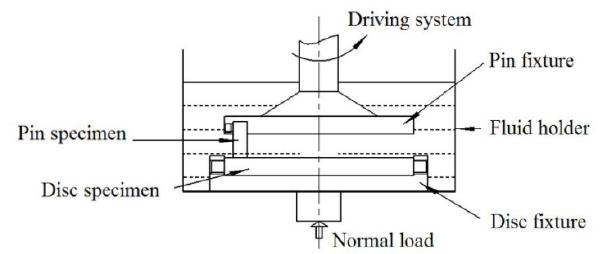
Figure 2. Schematic diagram of the friction and wear test apparatus.